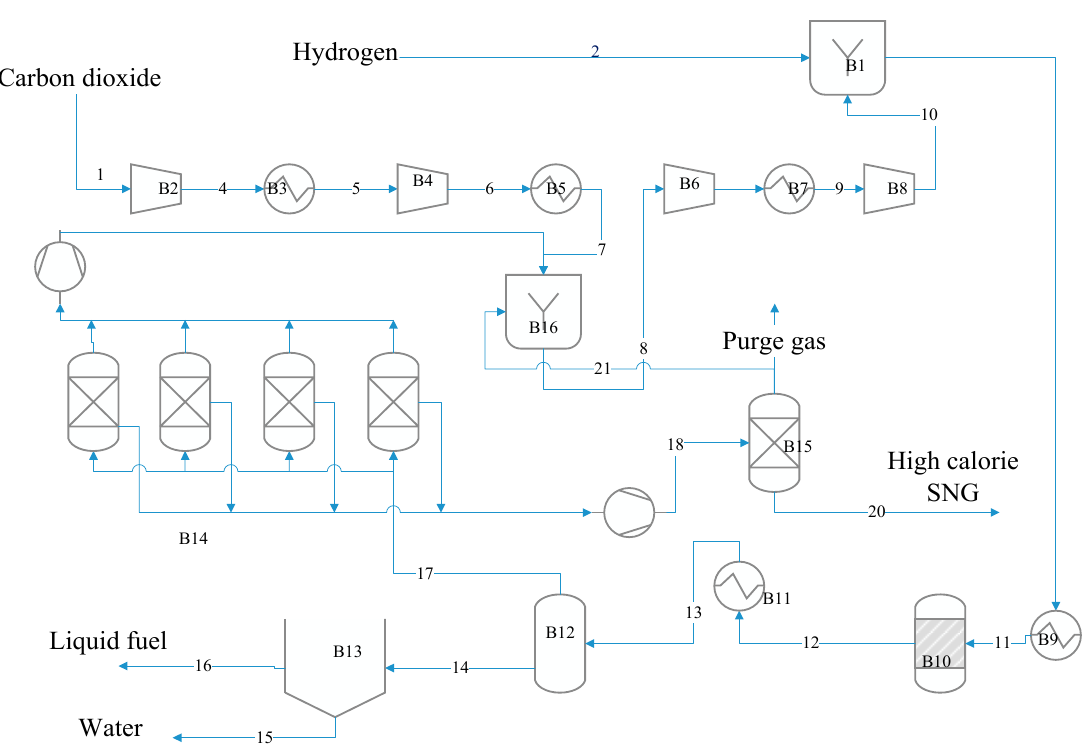
Figure 9. Schematic diagram of the Fischer–Tropsch-based hybrid PTG/PTL process. Major equipment: (B2, B4, B6, B8) compressor for feed compression; (B3, B5, B7) compressed feed cooler; (B9) heat exchanger for feed preheating; (B10) 2–phase Fischer–Tropsch reactor; (B13) heat exchanger (cooler); (B12) flash separator; (B15) user-defined CO 2 adsorption desorption unit; (B14) PSA unit for hydrogen separation.